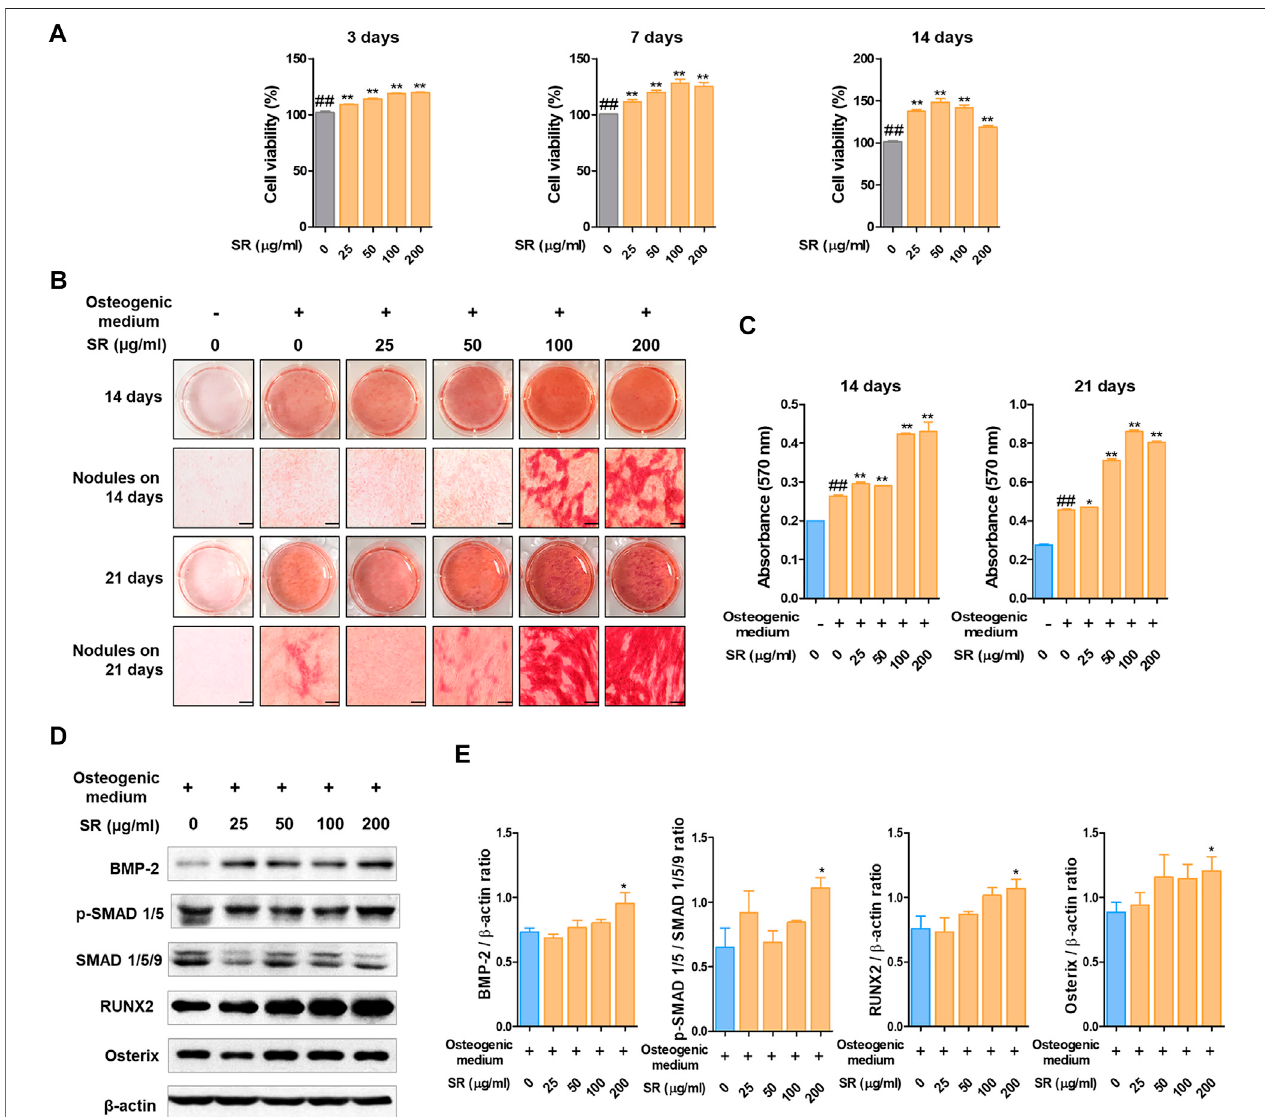
FIGURE 6 | The effects of SR on osteoblast differentiation. (A) MC3T3-E1 cell viability was analyzed by CCK-8 assays at 3, 7 and 14 days. (B) Calci fi ed nodules producedbyosteoblastswerestainedwithAlizarinRedSfor14and21 days. (C) TheabsorbanceofAlizarinRedSstainingdyewasmeasuredusinganELISAreaderat 450 nm. (D) Protein expression levels of BMP-2, p-Smad 1/5, RUNX-2 and Osterix were measured by western blotting. (E) BMP-2, RUNX-2 and Osterix levels were normalized to that of β -actin. p-Smad 1/5 levels was normalized to that of Smad 1/5/9. Data are presented as the mean ± SD of three independent experiments. Statisticalanalysiswasperformedusingone-wayANOVAfollowedbyDunnett ’ sposthoctest. ## p < 0.01vs.thenormalgroup(untreatedcells);* p < 0.05,** p < 0.01vs. the osteogenic medium-treated